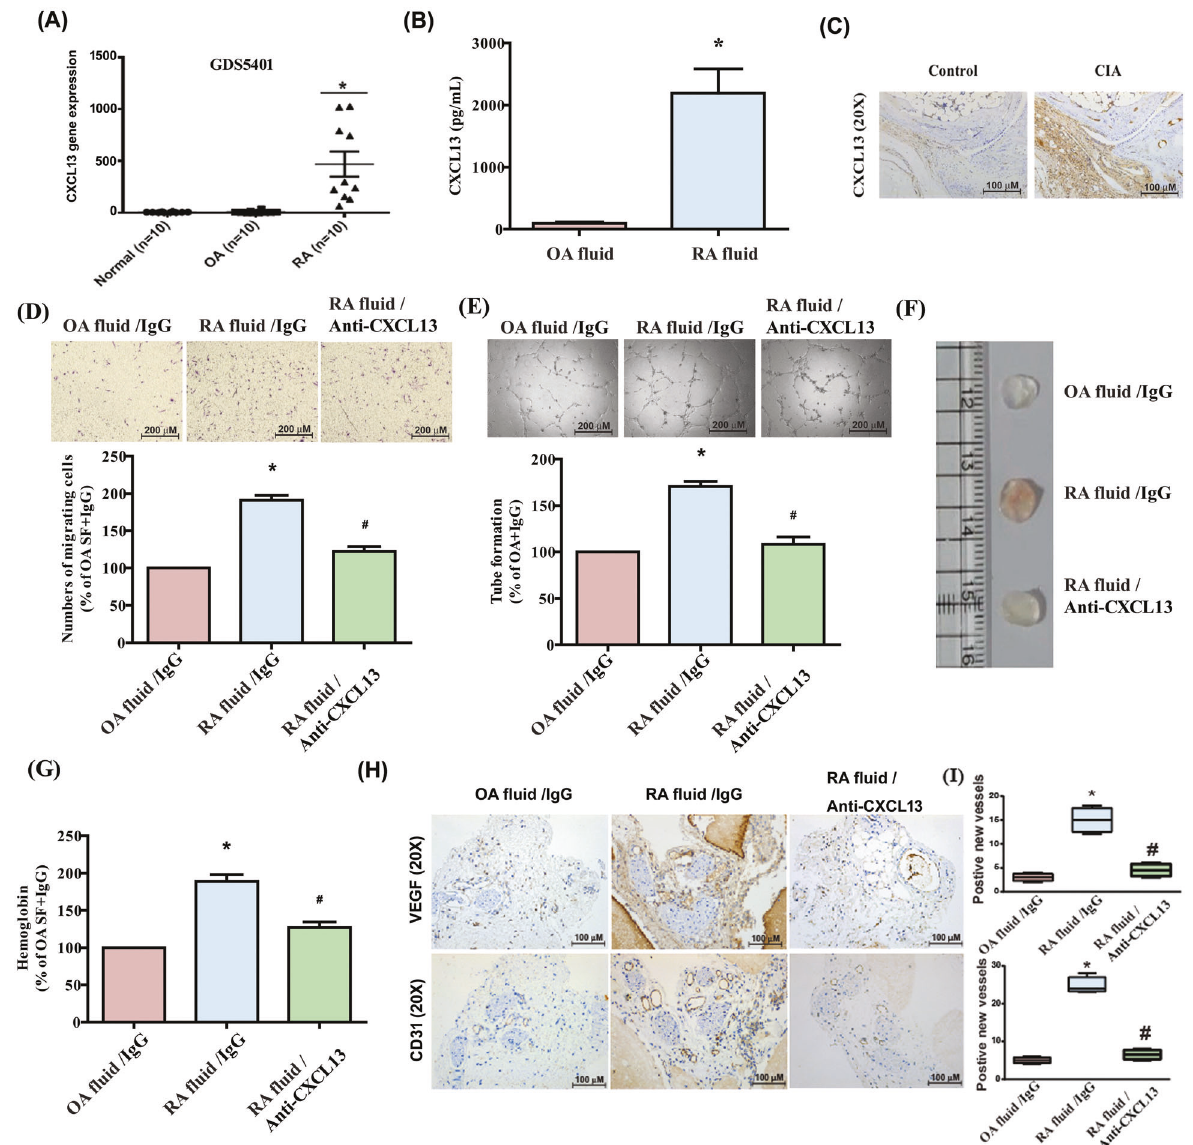
Fig. 1 Upregulation of CXCL13 expression in RA promotes EPC homing and angiogenesis. A Expression levels of CXCL13 in normal healthy individuals, as well as OA ( n = 10) and RA ( n = 10) patients, were retrieved from the GEO database (accession code: GDS5401). B CXCL13 levels in OA and RA synovial fl uid samples were quanti fi ed by the ELISA assay ( n = 6). C IHC staining of CXCL13 in ankle joints of controls and CIA mice ( n = 6). D and E RA synovial fl uid was treated with or without CXCL13 antibody, then applied to EPCs, before measuring EPC migration ( n = 6) and tube formation ( n = 6). F Matrigel plugs containing OA synovial fl uid plus IgG, RA synovial fl uid plus IgG, or RA synovial fl uid treated with CXCL13 antibody were subcutaneously injected into the fl anks of nude male mice ( n = 6). G After 7 days, the plugs were photographed and hemoglobin levels were quanti fi ed. H Plug specimens were immunostained with antibodies against CD31 and VEGF ( n = 6). I The new positive new vessels of ( H ) was quanti fi ed. * p < 0.05 versus OA synovial fl uid; # p < 0.05 versus RA synovial fl